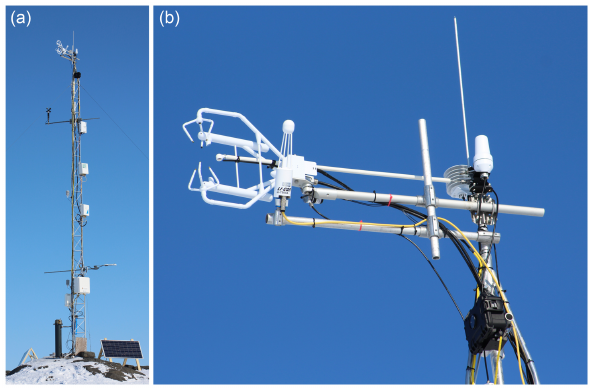
Figure 3. Mean tube delay obtained from 574 inlet tests. Blue cir- cles show the state of the solenoid valve (0 = closed; 1 = opened) responsible for releasing compressed N 2 directly in front of the sample tube inlet to the closed-path IRGA. The red triangles rep- resent the decay in the CO 2 mixing ratio from its pre-test steady state (1) to its settled value during the test (0).